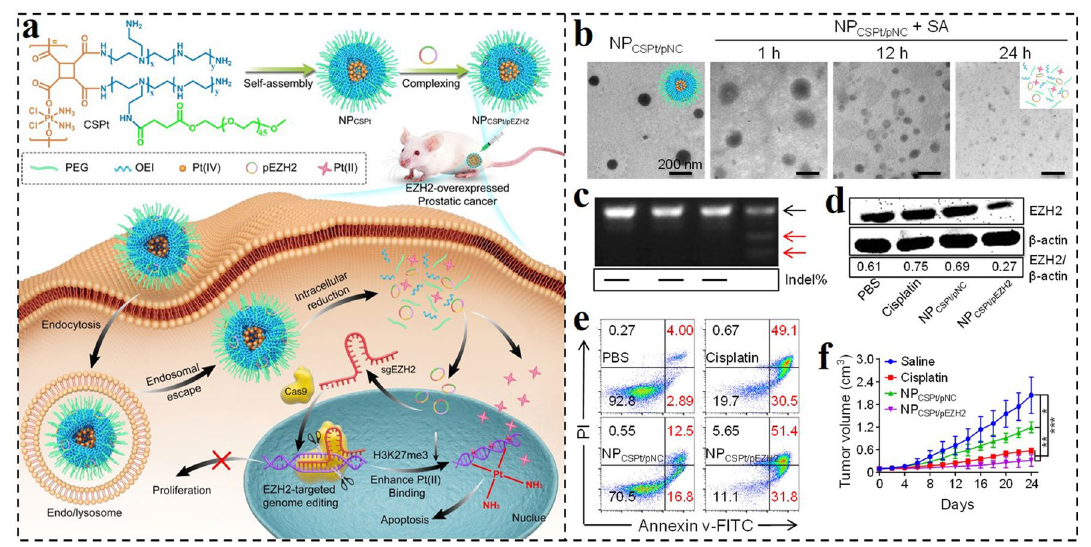
Fig. 8 a Schematic illustration of the chain-shattering Pt(IV)-backboned polymeric nanoplatform delivering EZH2-targeted CRISPR/Cas9 sys- tem (NP CSPt/pEZH2 ) for effective gene editing-chemo synergistic treatment of prostate cancer. b Morphology changes of NP CSPt/pNC after incuba- tion with ascorbic acid for different time intervals. c Mutation frequency analysis of the targeted sites of EZH2 by T7EI assay. d EZH2 protein expression levels in PC-3 cells by Western blot assay after different treatments. e Apoptosis analysis of PC-3 cells by flow cytometry after differ- ent treatments. f Tumor volume changes of mice during the experiment [163]. Copyright 2020, Tsinghua University Press and Springer-Verlag